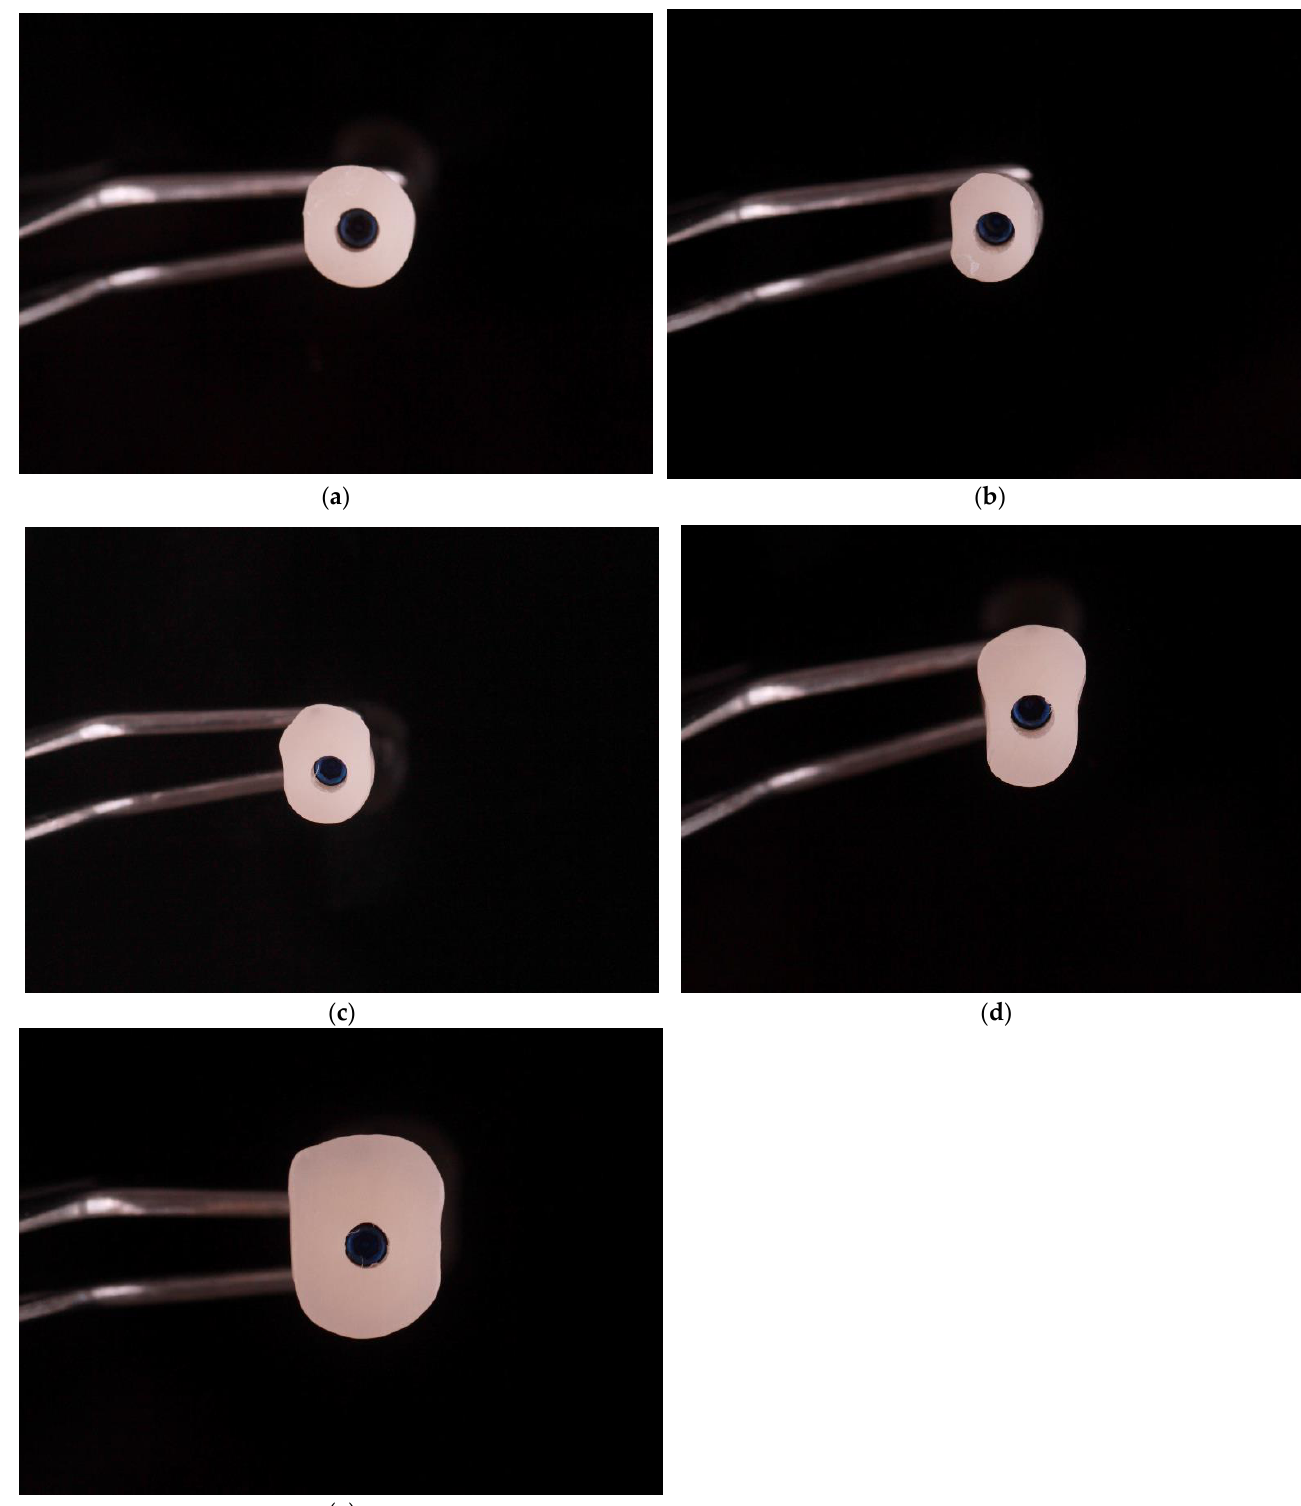
Figure 4. The laboratory design of the healing abutment for the ( a ) central incisor, ( b ) lateral incisor, ( c ) canine, ( d ) first premolar, and ( e ) first molar in the upper jaw.